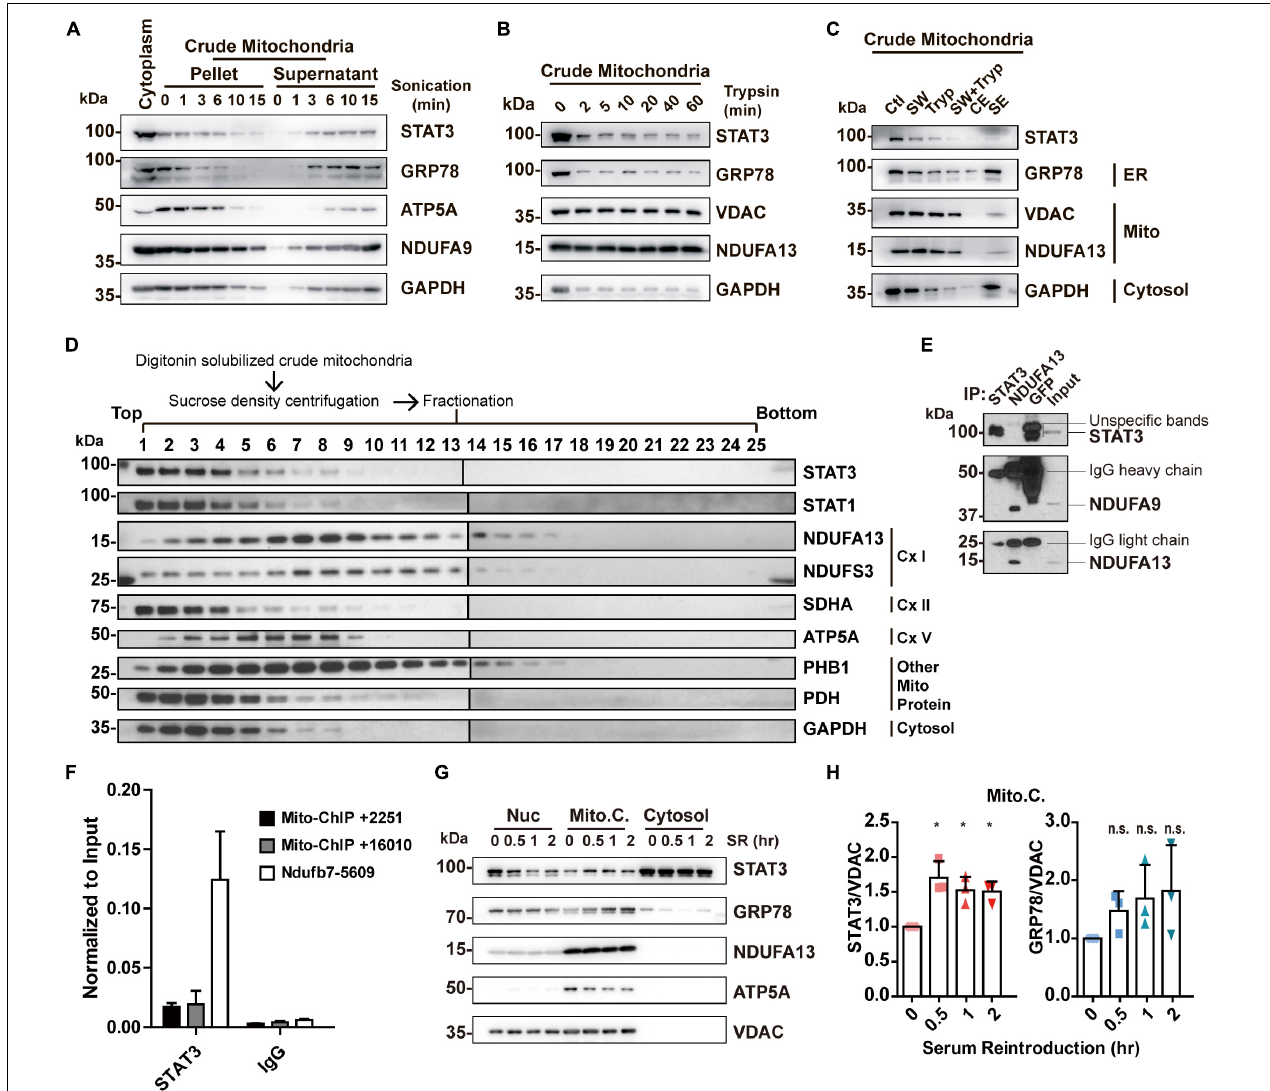
FIGURE 3 | Re-examining the existence and function of ‘mitochondrial STAT3.’ (A) Purification of mitochondria by sonication. (B) Purification of mitochondria by trypsinization. (C) Purification of mitochondria by washing with high concentration of salt combined with trypsinization. GRP78 was used as the ER marker; ATP5A, NDUFA9, NDUFA13, and VDAC were used as the mitochondrial marker; GAPDH was used as the cytosolic marker. (D) Sucrose density centrifuge of digitonin-solubilized mitochondria followed by Western blot analysis of STAT3 and mitochondrial complexes protein. (E) Co-immunoprecipitation experiment in digitonin-solubilized crude mitochondria. (F) ChIP-qPCR detection of STAT3-binding on mitochondrial DNA in mouse embryonic stem cells. (G) Serum reintroduction experiment in Neuro2A cells. (H) Quantification of Western blot results (G) in three independent experiments. * p < 0.05, n.s. not significant; Ctl, control (washed with isotonic buffer); SW, salt-washed; Tryp, Trypsinized; CE, control elute; SE, salt-washed elute; Cx I, complex I; Cx II, complex II; Cx V, complex V; Nuc, nuclear fraction; Mito.C., crude mitochondrial fraction; SR, serum